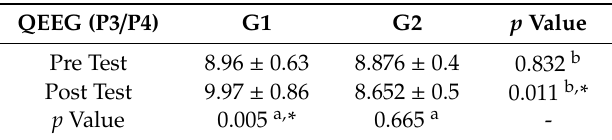
Table 5. The mean values of peak frequency of the alpha wave of sensory areas (P3 / P4) of the a ff ected hemisphere in (G1) and